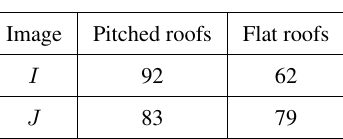
Table 3: The Quality measure (%) of the clustering method in categorizing the buildings into pitched and flat roofs for images I and J